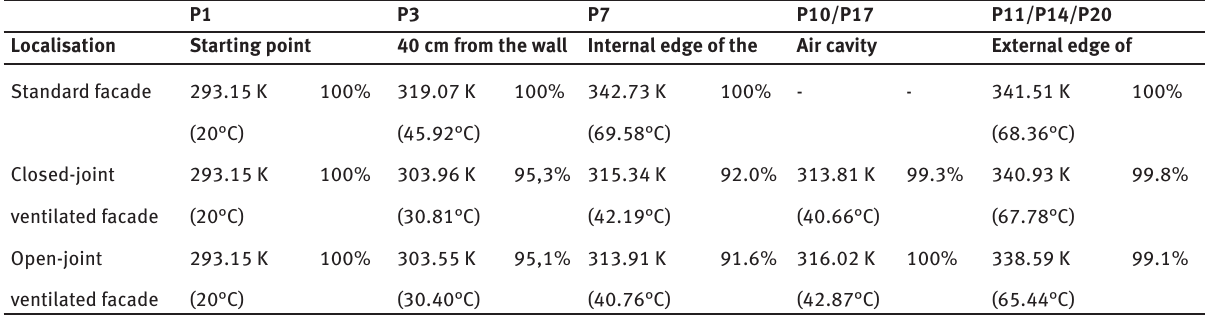
Table 2: Characteristic values of temperature. P1